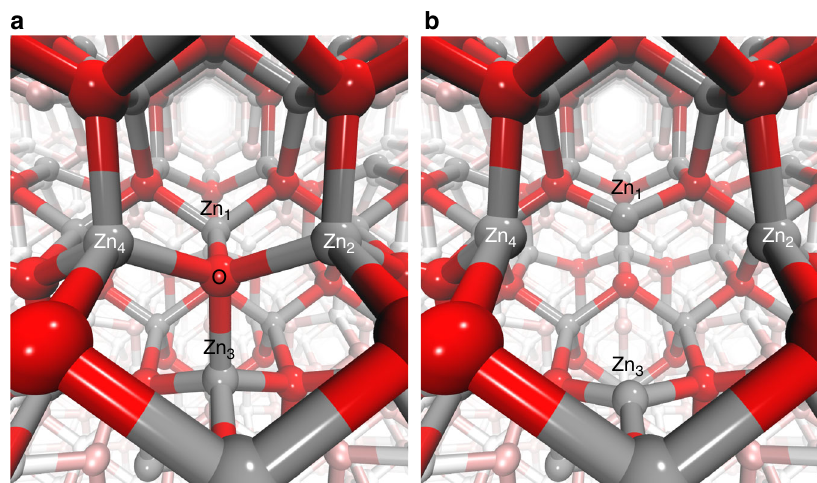
Fig. 6 Structural changes. a Schematic of the ZnO structure without the oxygen vacancy, which is the dominant structure probed in the ground state, and ( b ) structural distortion around the V 2 þ vacancy, which occurs upon the trapping of a hole at a V þ O the four nearest neighbour Zn atoms (Zn 1 – 4 )